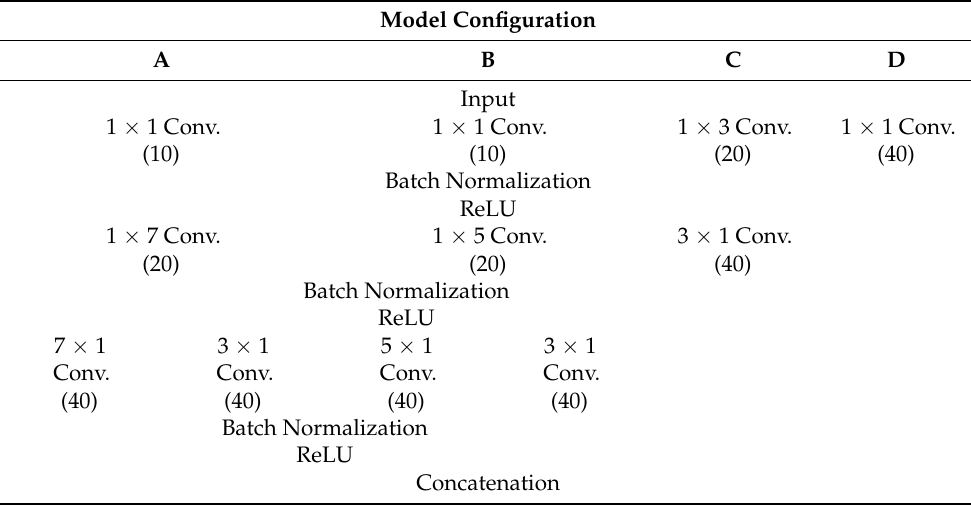
Figure 4. Examples of temporal and spatial convolutions. Table 1. Details of multi-scale feature extraction